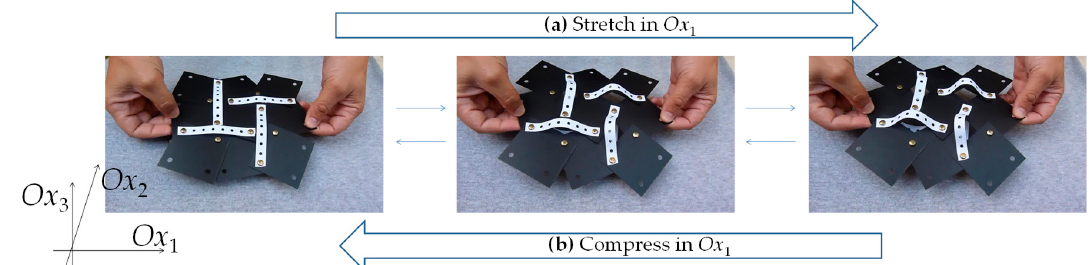
Figure 4. Image showing a ‘monolayer’ physical prototype ( a ) being stretched in the Ox 1 direction or ( b ) compressed. Note that on stretching in Ox 1 , there is an increase in width in the Ox 2 direction due to the rotating squares mechanism and an increase in thickness in the Ox 3 direction due to the proposed triangular elongation mechanism (TEM), which is implemented here through thin flat ligaments which flex out of plane (see the animation). Note also that, despite the crudeness in construction of the physical prototype (squares made from regular sheets of c . 0.4 mm plastic, TEM implanted via a thin sheet of perforated paper c. 0.1 mm in thickness and 90 mm in length, and connections provided by regular office brass fasteners), there is still a remarkable similarity with the idealized hinging model presented above.